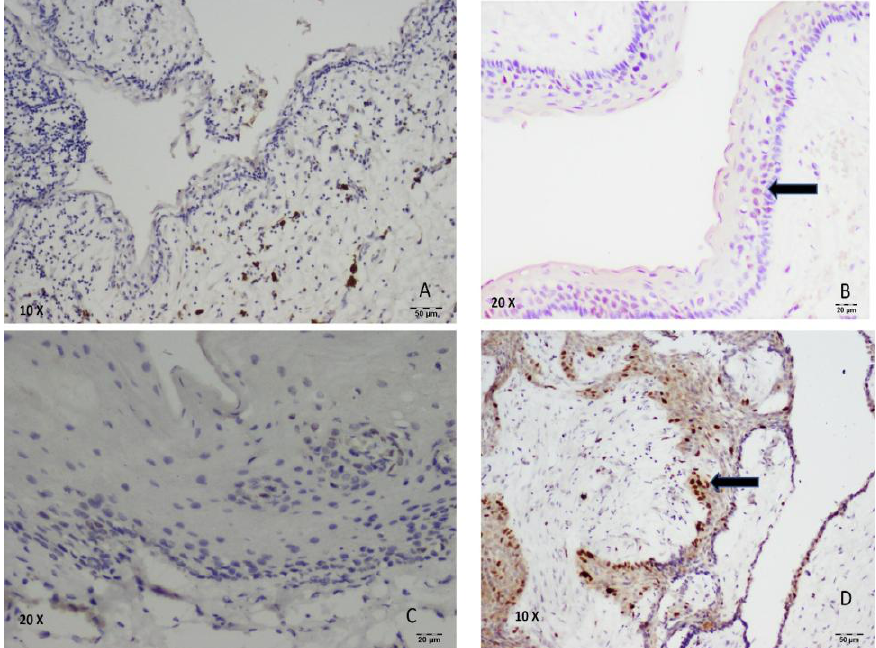
Figure 5. A. Dentigerous cyst (Absence of expression of Ki 67) B. Odontogenic Keratocyst (Ki-67 expression in the basal and supra basal cells of the odontogenic epithelial lining) C.